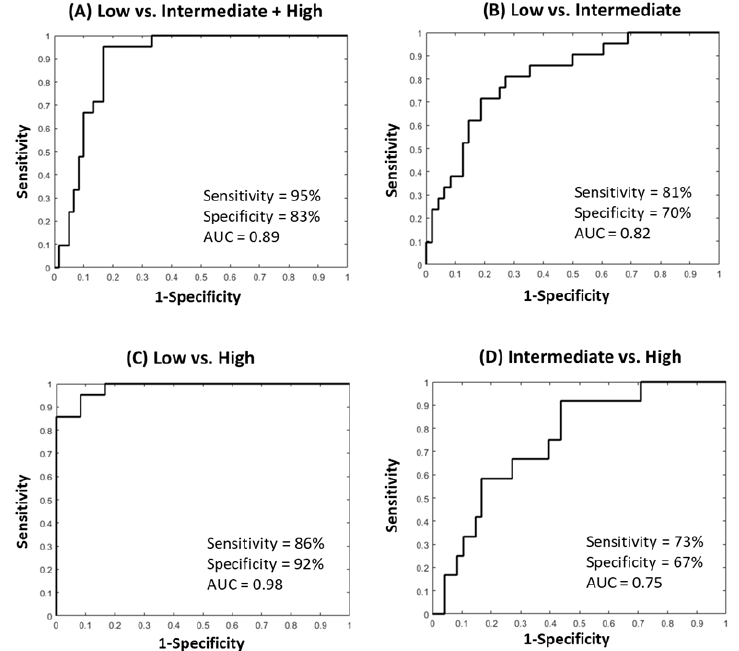
Figure 7. The Area under the Curve (AUC) graphs of the mpRad IsoSVM model trained